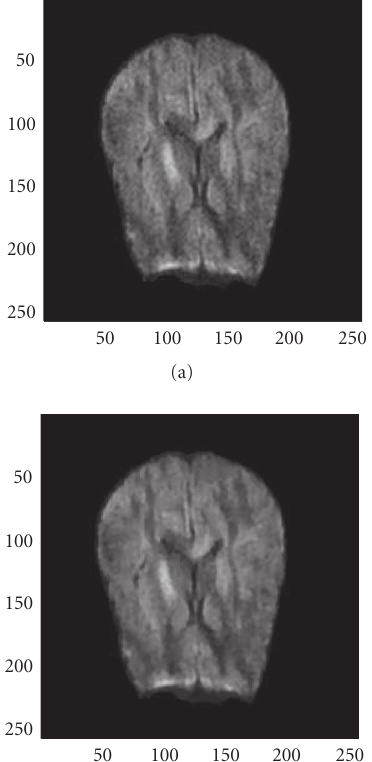
Figure 4: (a) Original image. (b) Denoised image using the TV wavelet